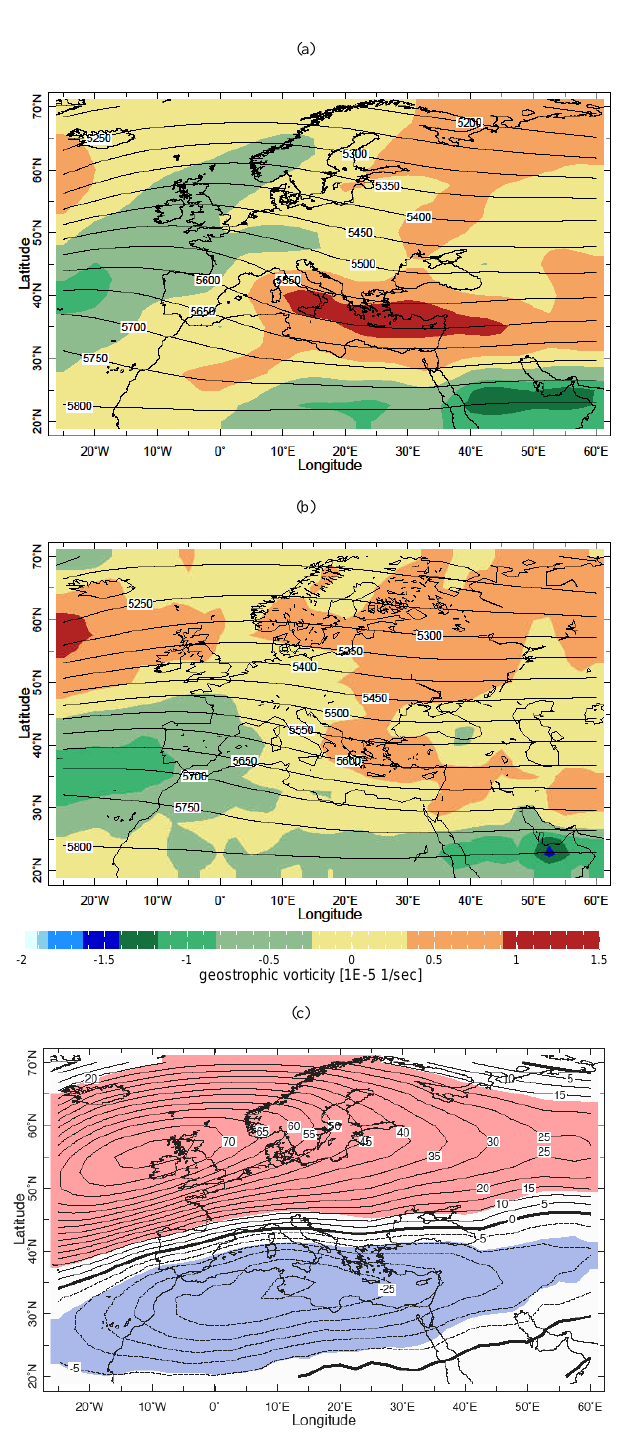
Fig. 8. Long-term mean gph for DJF (contours, in meters) and geostrophic relative vorticity (in 10 − 5 s − 1 units, shaded), both at 500-hPa, for (a) observations and (b) simulations. (c) The 500hPa gph difference between them (b–a) . The sign and significance of the trend is represented as in Fig.